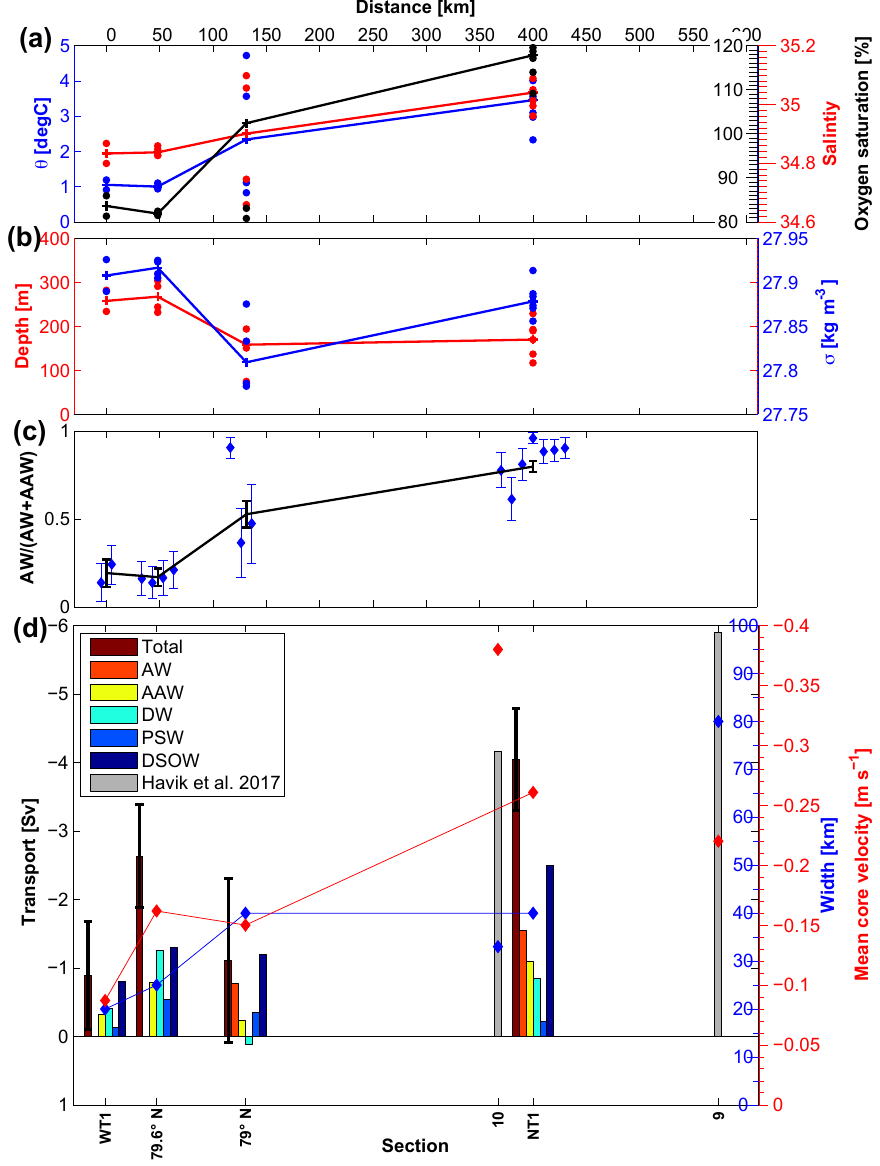
Section Figure 7. Properties of the θ maximum in the shelf break EGC from north to south: (a) potential temperature, salinity and oxygen saturation; (b) depth and potential density; and (c) AW fraction as a function of AW + AAW for individual stations (blue, horizontally offset for clarity) and for the average at each section (black). Error bars show the ± 1 standard deviation. Transport, velocity and width of the shelf break EGC in the Fram Strait as defined in Håvik et al. (2017) are shown in (d) . Southward transport is negative. Water-mass definitions are as in Table 1. Downstream distance (in km) is 0km at WT1 and follows the east Greenland shelf break southward. Values for sections 9 and 10 of Håvik et al. (2017) are taken from their